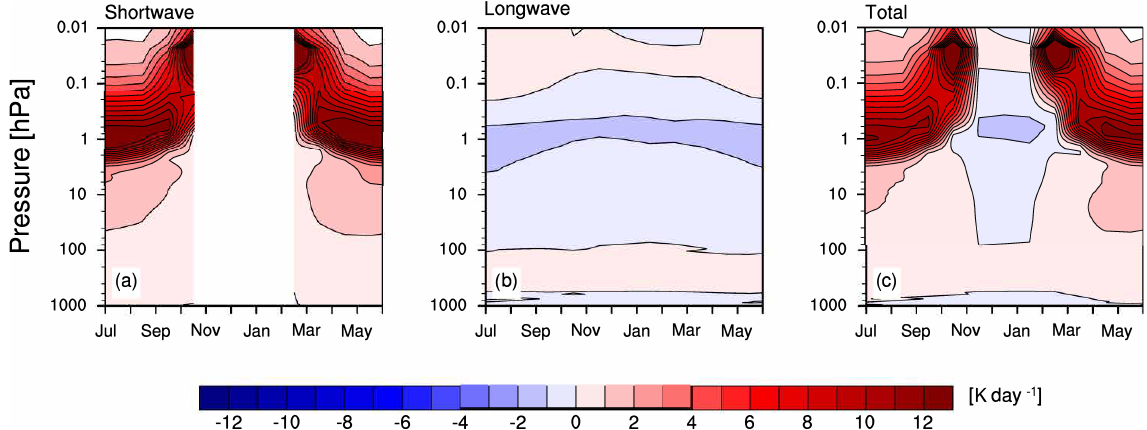
Figure 1. Monthly mean heating rates of ozone (Kday − 1 ) for 75 ◦ N calculated by the radiative transfer model PSrad for (a) short- wave, (b) longwave, and (c) total (shortwave + longwave) radiation.